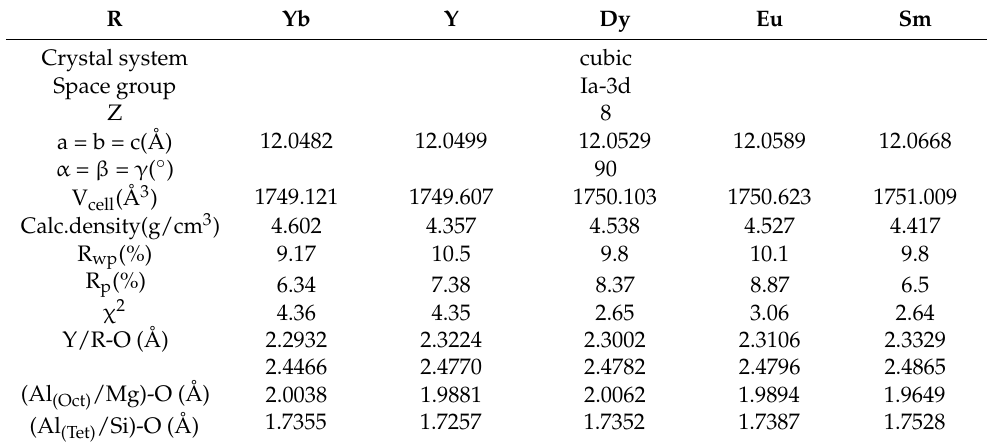
Table 1. The crystallographic data obtained by Rietveld refinement for Y 2.95 R 0.05 MgAl 3 SiO 12 ceramics.